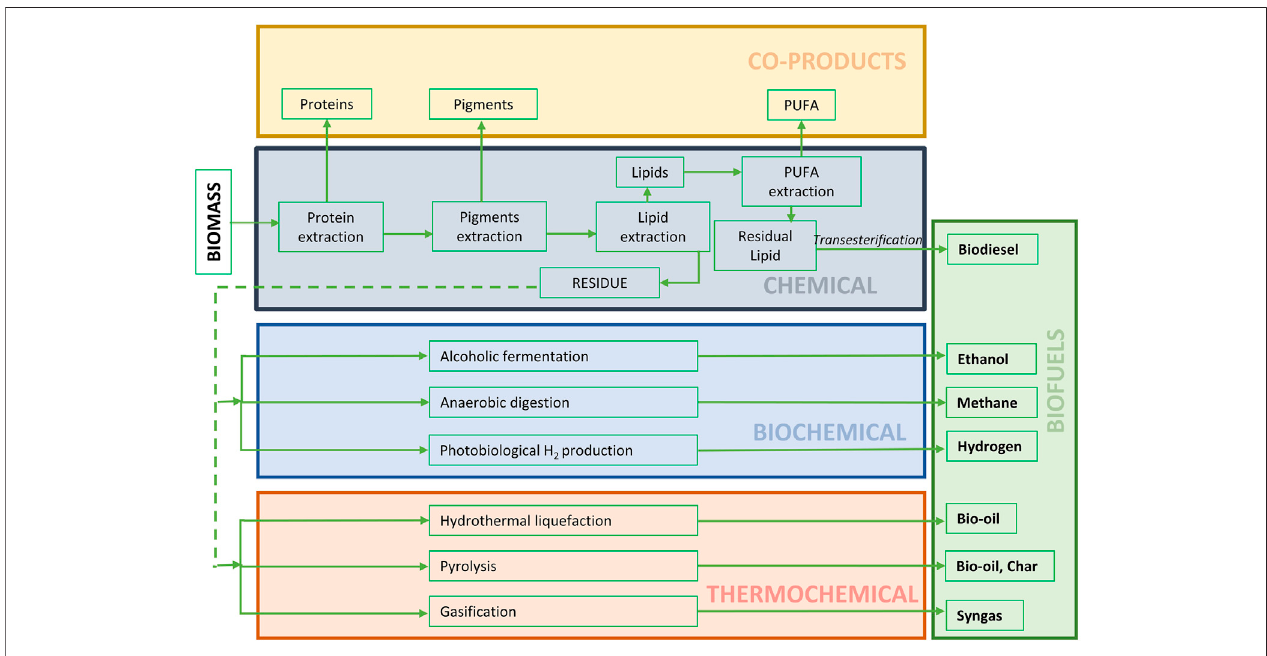
FIGURE 2 | Integrated algal biore fi nery process for biofuels and other value added co-products.